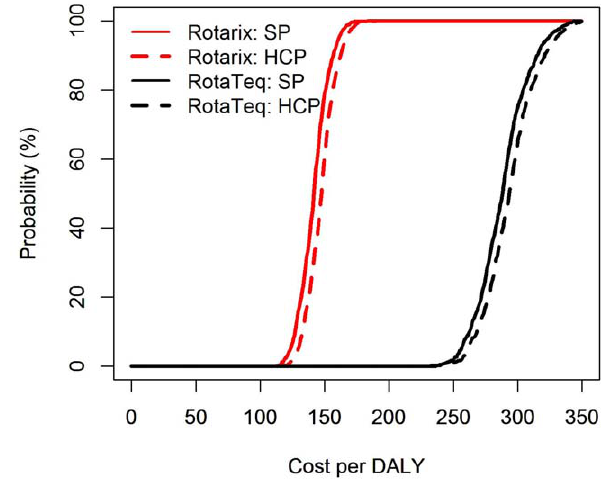
Figure 3. Cost-effectiveness acceptability curve for Rotarix (red) and RotaTeq (black) following vaccine introduction in Kenya modelled over a five year period. The Societal Perspective (SP) is the solid line, the Health Care Perspective is marked by the dashed line.